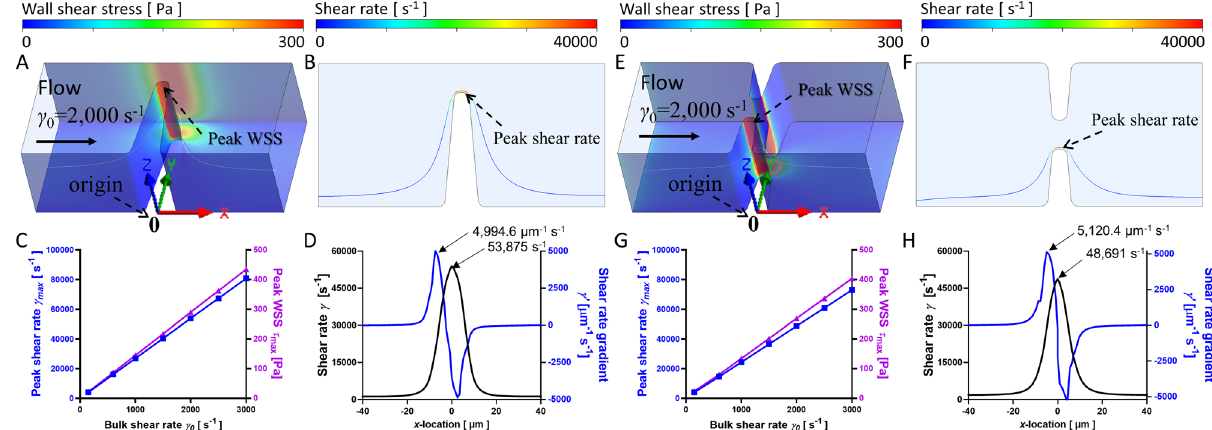
Figure 2. CFD simulated shear rate, WSS and shear rate gradient plot for eccentric ( A – D ) and concentric ( E – H ) stenosis microfluidics under various bulk shear rates. ( A and E ) The cross-section WSS view of the eccentric ( A ) and concentric ( E ) stenoses microfluidic for γ 0 = 2,000 s −1 . Note that the WSS occurs at the middle of stenotic region. ( B and F ) The streamline of blood flow in the eccentric and concentric stenosis microfluidic channel for γ 0 = 2,000 s −1 . The representative streamline of a platelet trajectory was colored by shear rate values. Note that the peak shear rate γ max occurs at the stenosis apex. ( C and G ) The peak shear rate γ max and peak WSS τ max linearly correlated with the input bulk shear rate γ 0 for both eccentric and concentric stenosis microfluidics respectively. ( D and H ) The shear rate and shear rate gradient history of a single platelet particle trajectory 30 μm from the bottom wall and 1 μm from the symmetric geometry surface at γ 0 = 2000 s −1 for eccentric and concentric stenosis microfluidic channels. Note that the γ max ≈50,000 s −1 and γ ’ max ≈5,000 µm −1 s −1 for eccentric and concentric stenosis respectively.